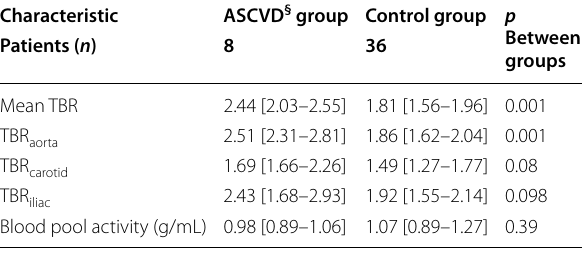
§ ASCVD atherosclerotic cardiovascular disease